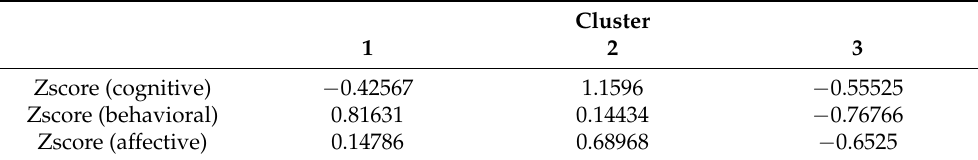
Table 7. Final cluster centers.